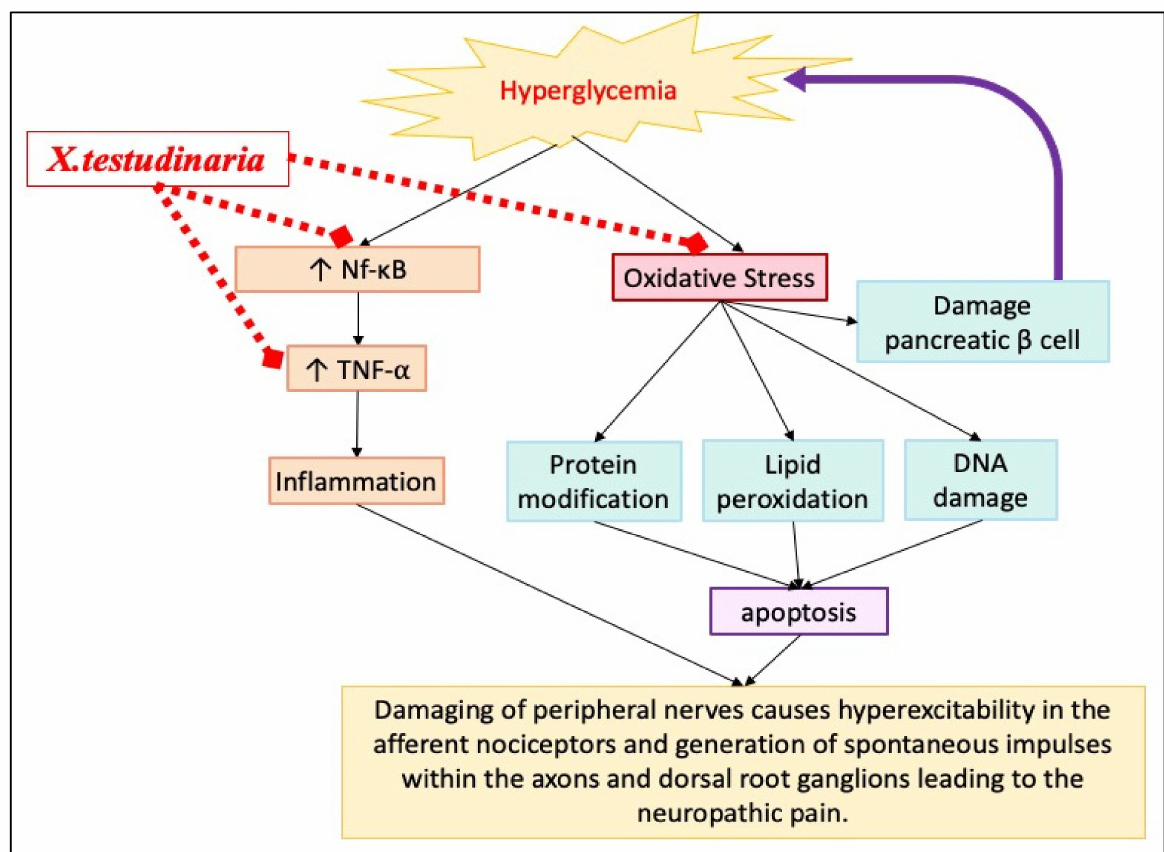
Figure 9. A schematic overview of pathogenesis of diabetic neuropathy and possible mechanism (s) through which X. testudinaria extract could exert its diabetic neuroprotective